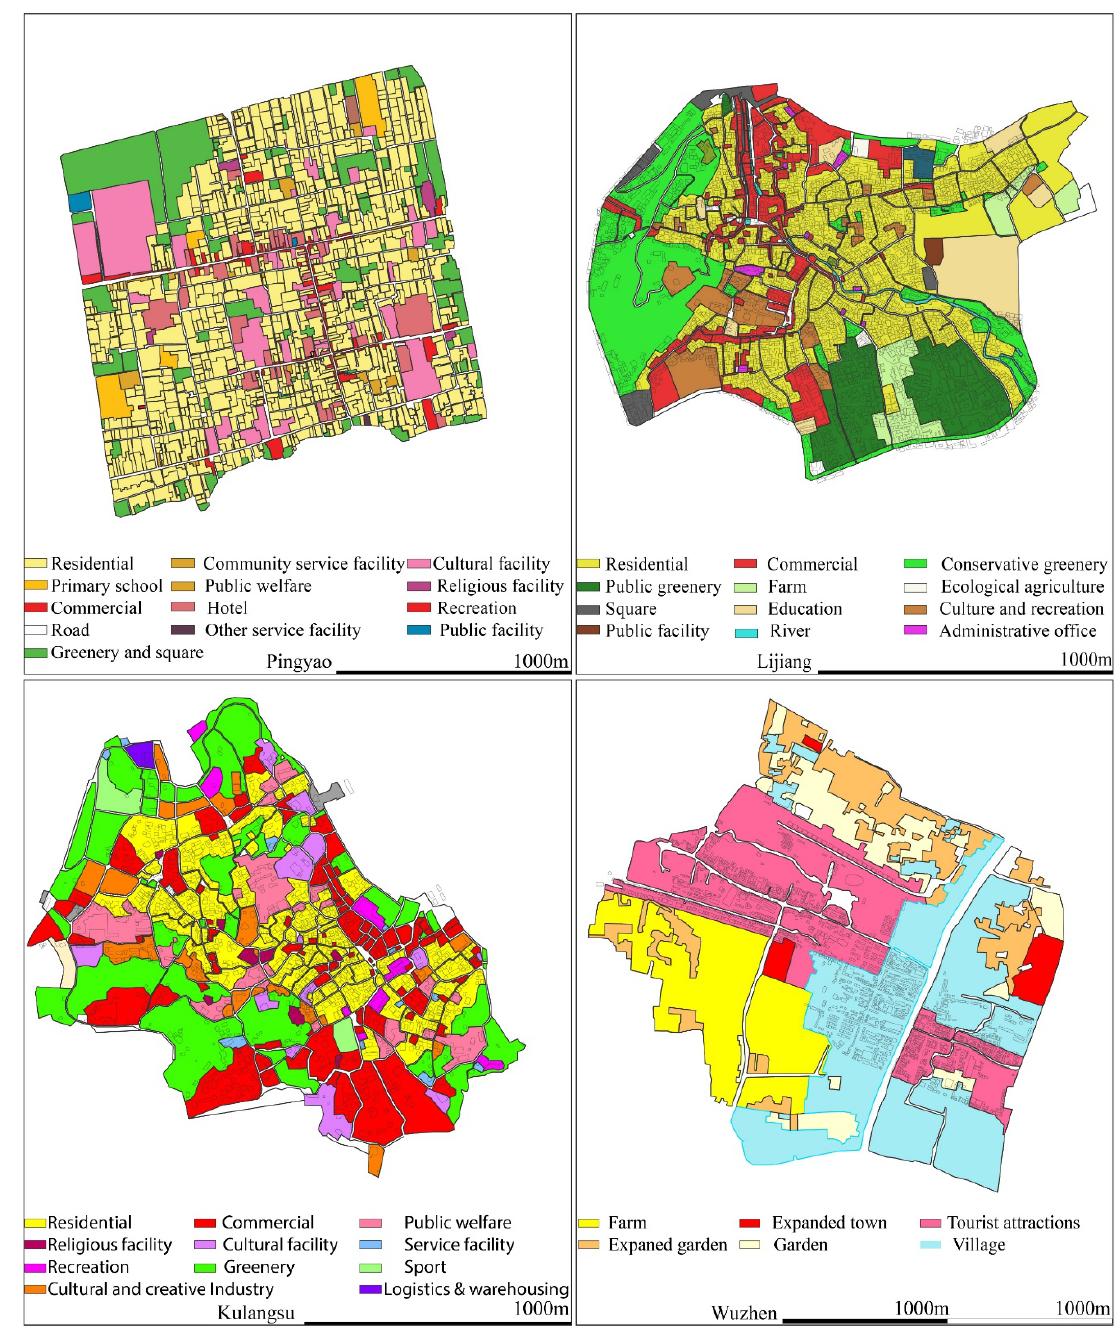
Figure 4. The planned land uses of the four